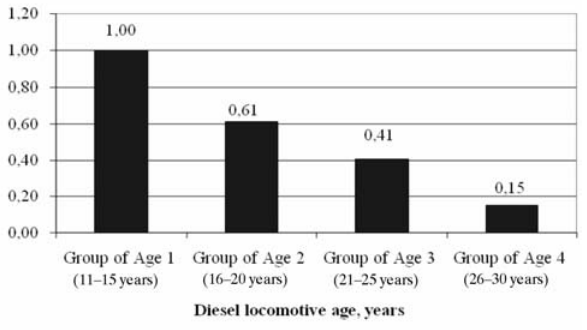
Fig 1. The relationship between the value of integrated performance indicator and the locomotive age (obtained by the first method of evaluation) According to the second technique, a dimensionless performance indicator is obtained. Its value at the break point is assumed to be equal to 1.0. In Fig 2, the relation- ship between the dimensionless indicator and the locomo- tive age is